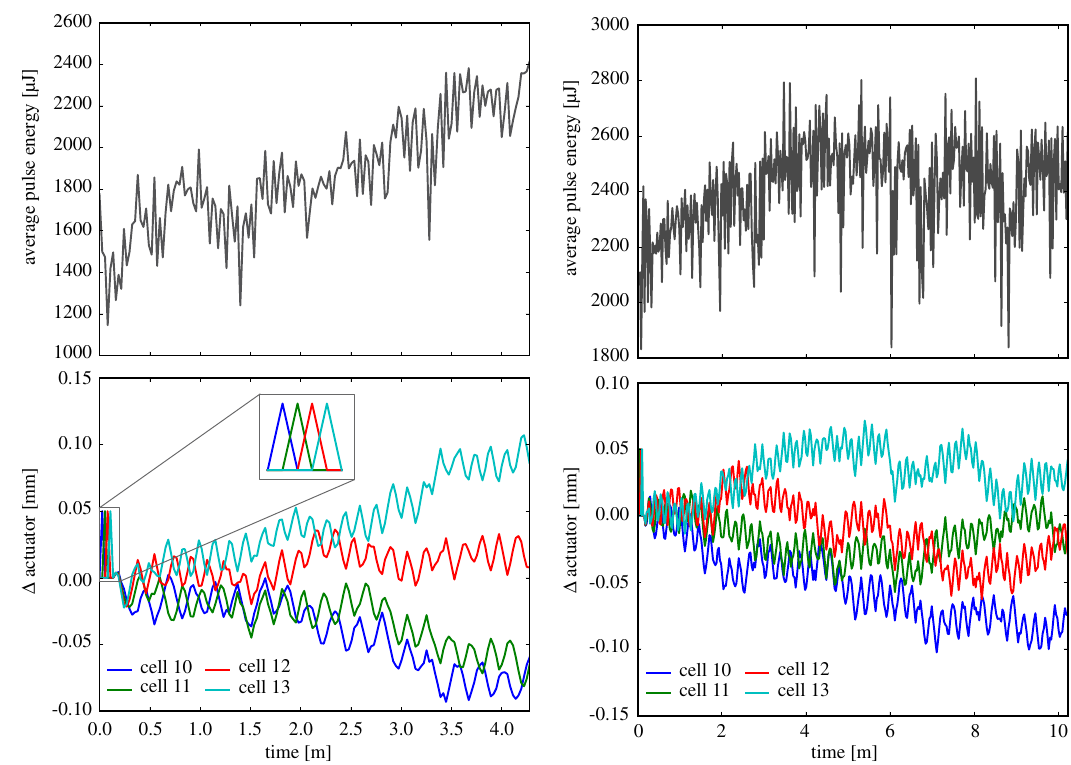
FIG. 13. Tuning 4 air coils to maximize average bunch energy. Left: An autotune was performed to calculate the k j , a zoom in on the initial 4 steps shows the parameters being changed one at a time during the autotune procedure. Optimization was run for 4 minutes. Right: A second autotune was then performed and optimization was run for an additional 10 minutes at which a local maximum was